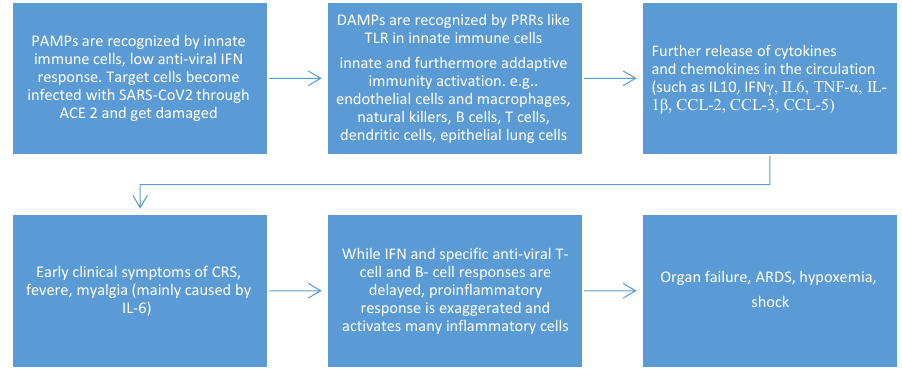
Figure 2 . Cytokine storm development in the course of